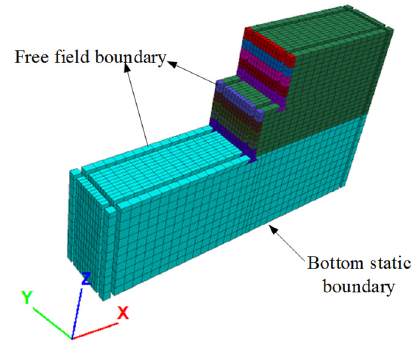
Figure 7. Boundary condition. Figure 7. Boundary